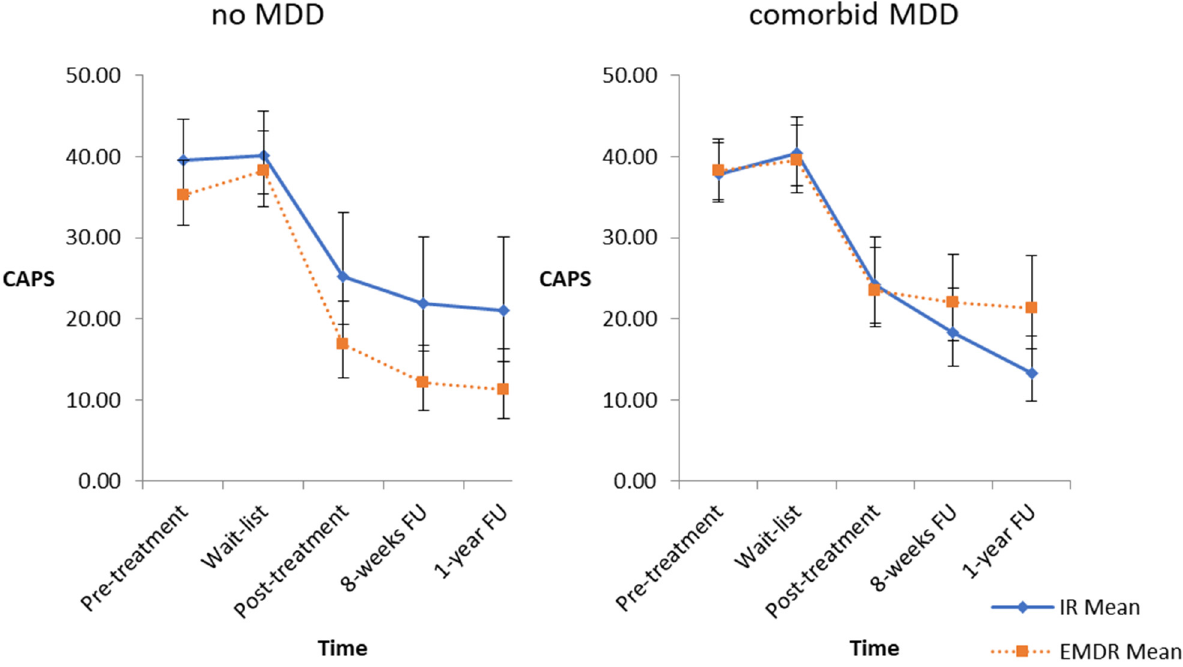
Figure 1. Course of posttraumatic stress symptoms in patients with and without major depressive disorder. Abbreviations: MDD = major depressive disorder; CAPS = clinician-administered PTSD scale for DSM-5; IR = imagery rescripting; EMDR = eye movement desensitization and reprocessing; FU = follow-up. Notes: Estimated CAPS means and 95-% confidence interval for all time points, treatment condition, and comorbid diagnosis of MDD.